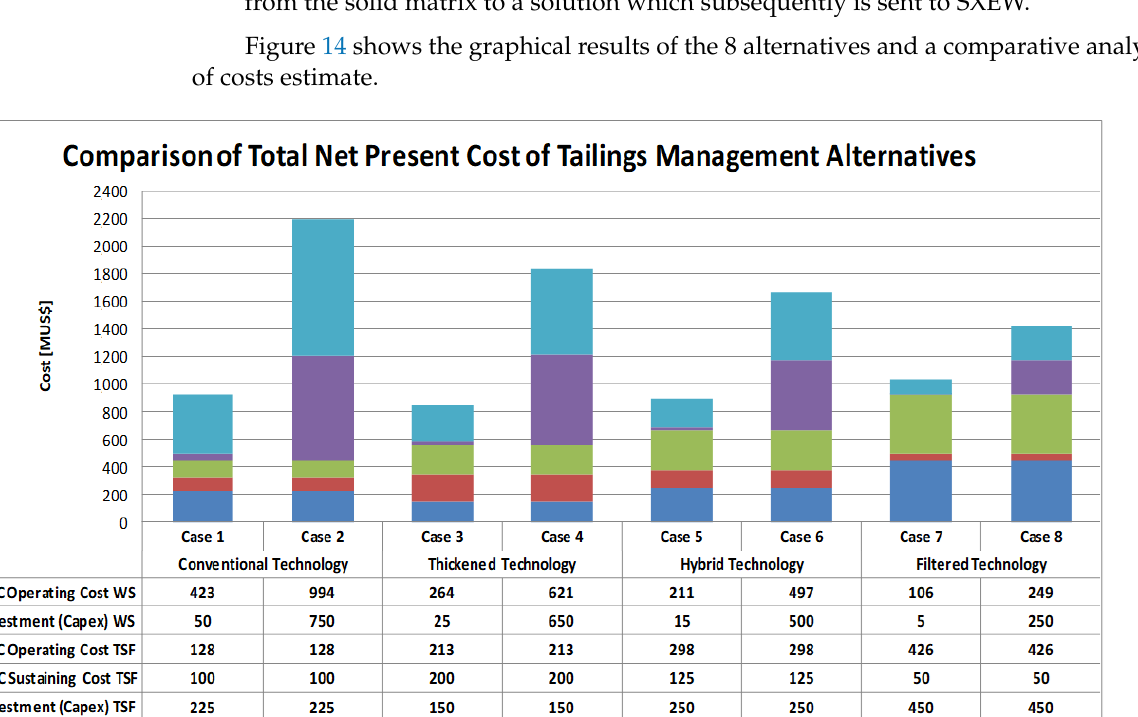
Figure 14. Results of Cost Estimate for Tailings Management Alternatives.